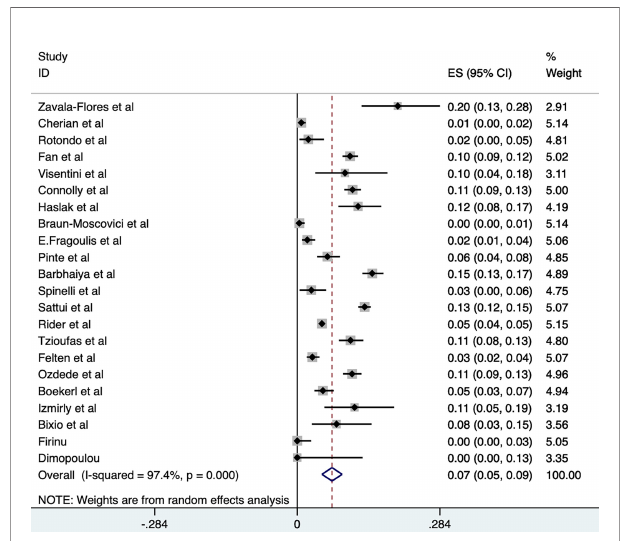
FIGURE 1 | Total fl are rate of rheumaticdisease after COVID-19